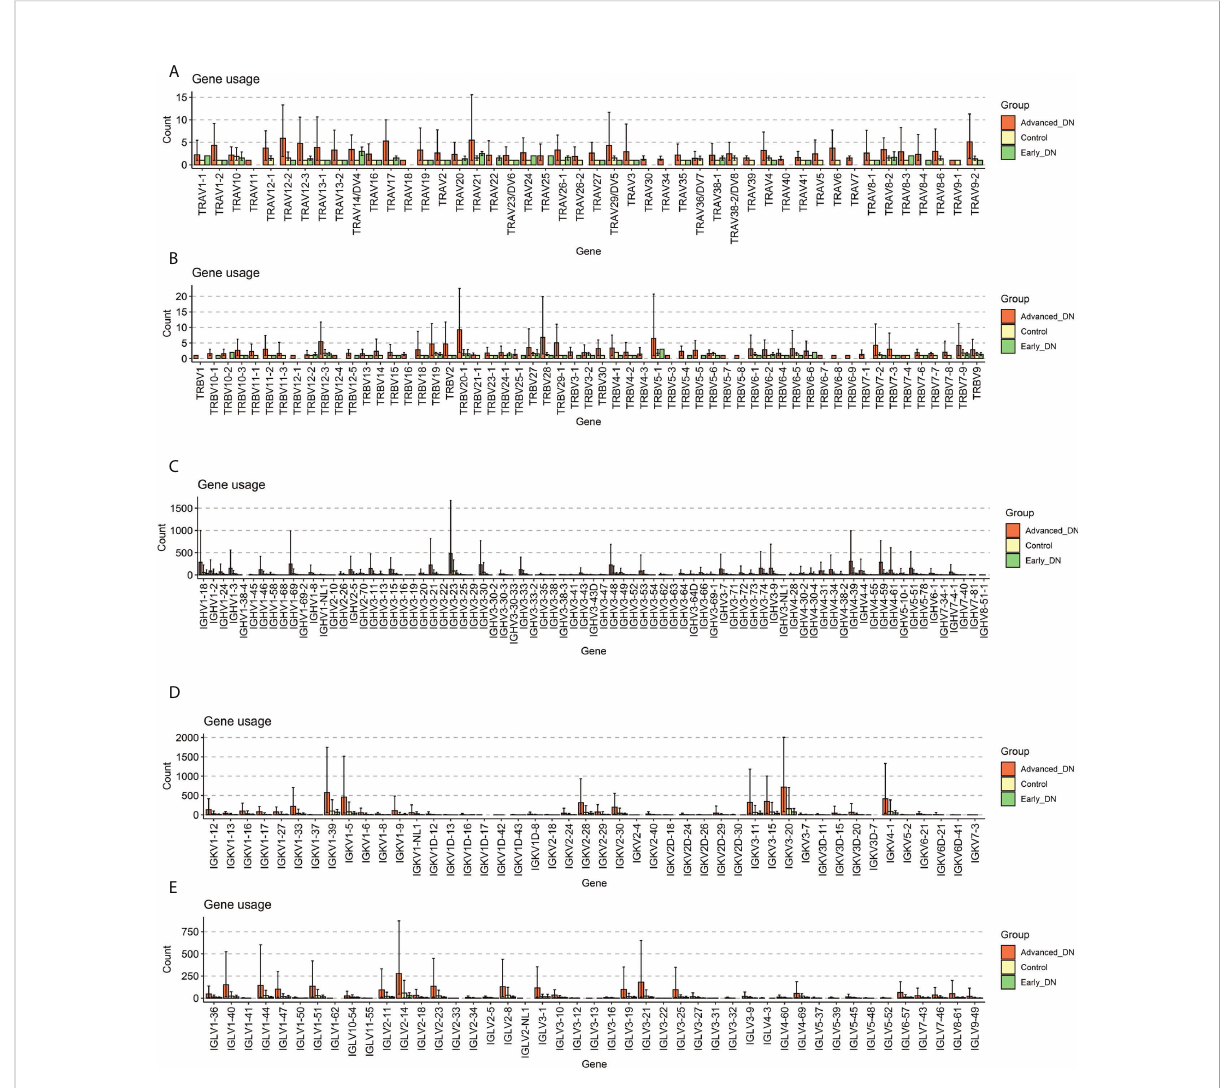
FIGURE 2 Gene usage analysis. (A) Comparison of Gene Usage of TRAV. (B) Comparison of Gene Usage of TRBV. (C) Gene Usage comparison of IGHV. (D) Gene Usage comparison of IGKV. (E) Comparison of Gene Usage of